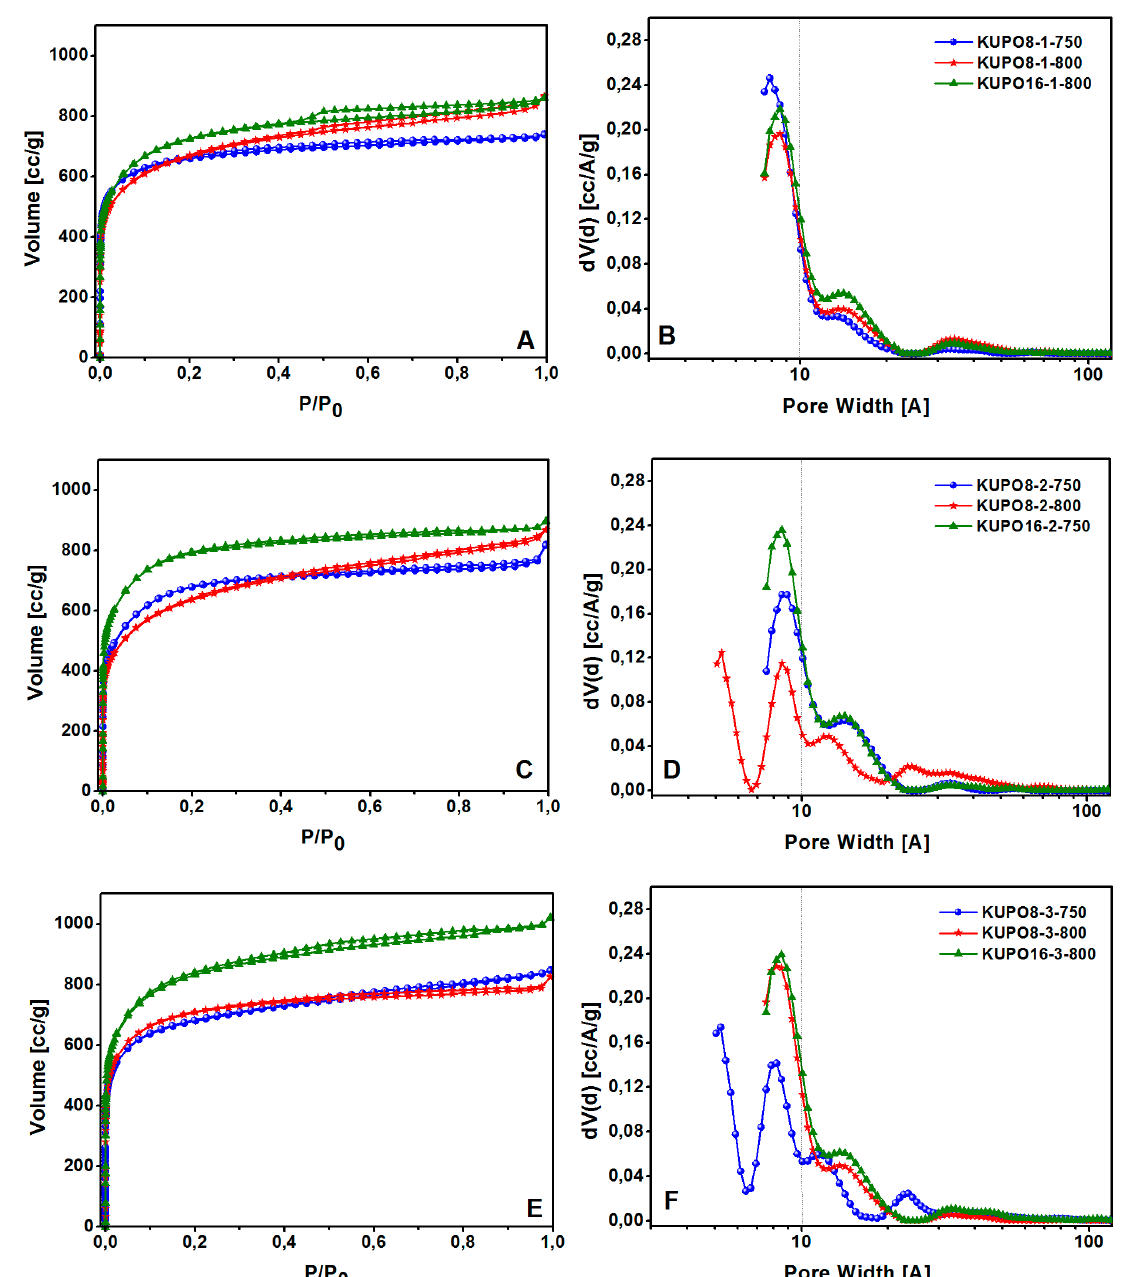
Figure 7. N 2 adsorption-desorption isotherms at 77 K and PSD of KUPO carbons obtained with method 1 ( A , B ), method 2 ( C , D ), and method 3 ( E , F ), respectively.